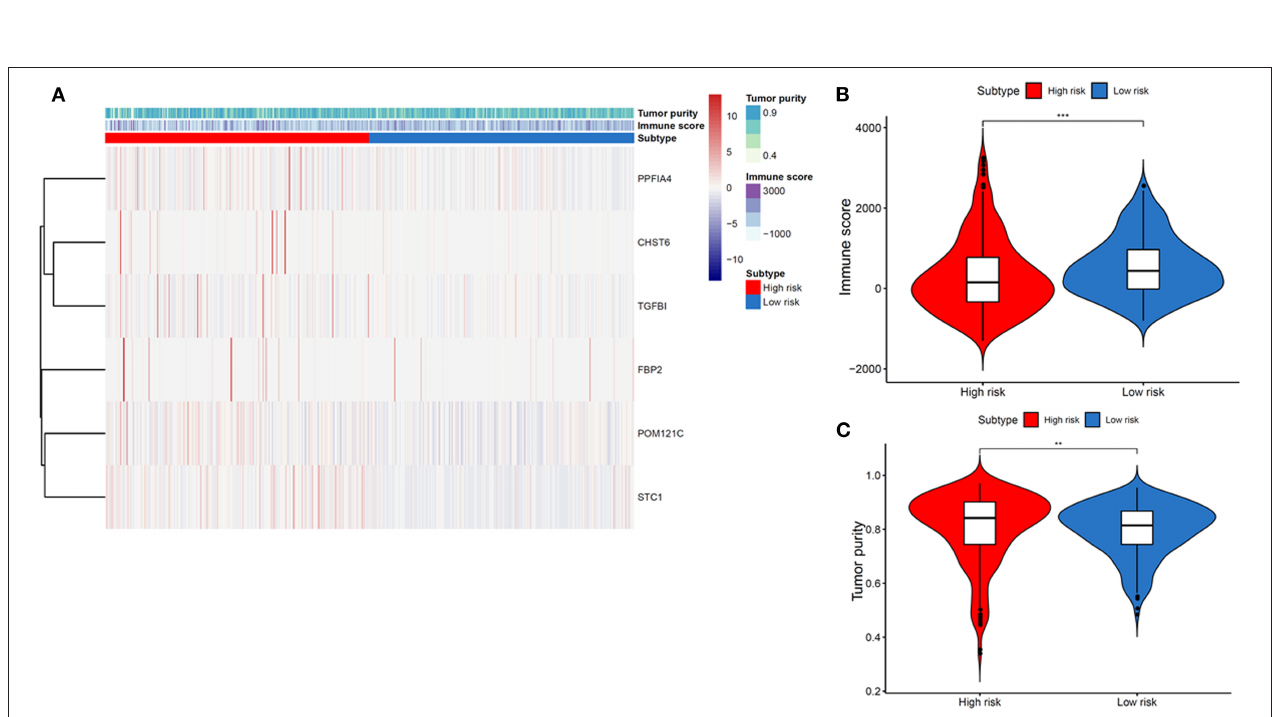
FIGURE 4 | Association between tumor immune microenvironment and gene signature-based subsets in THCA. (A) Heatmap indicating the relationship of THCA subtypes with the expression of tumor immune microenvironment. (B) Immune score in THCA subtypes. (C) Tumor purity in THCA subtypes.